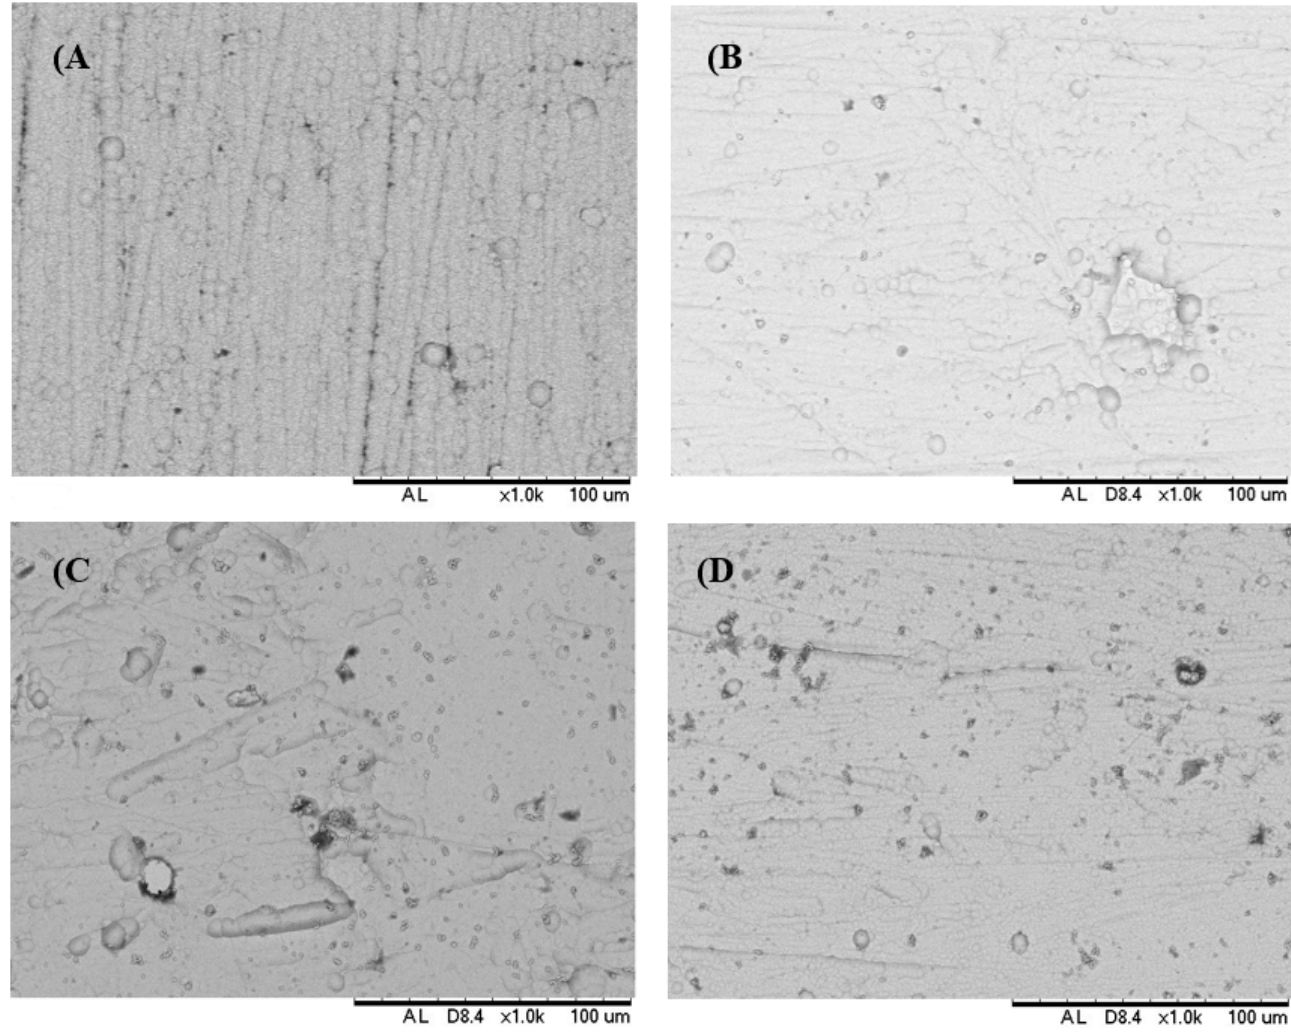
Figure 2. SEM micrographs of the top surfaces of the nickel-based coatings: ( A ) Ni–P; ( B ) CNT-0.25; ( C ) CNT-0.5; ( D ) CNT-1.0.